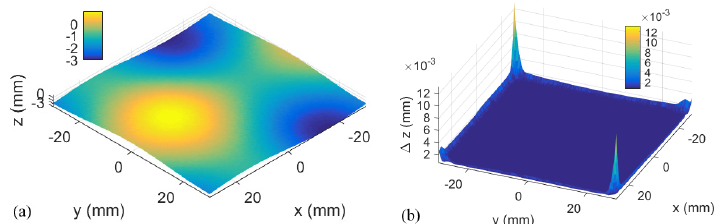
Figure 18. Mean surface and associated uncertainty after Gaussian process modelling: ( a ) mean surface; and ( b ) associated uncertainty.